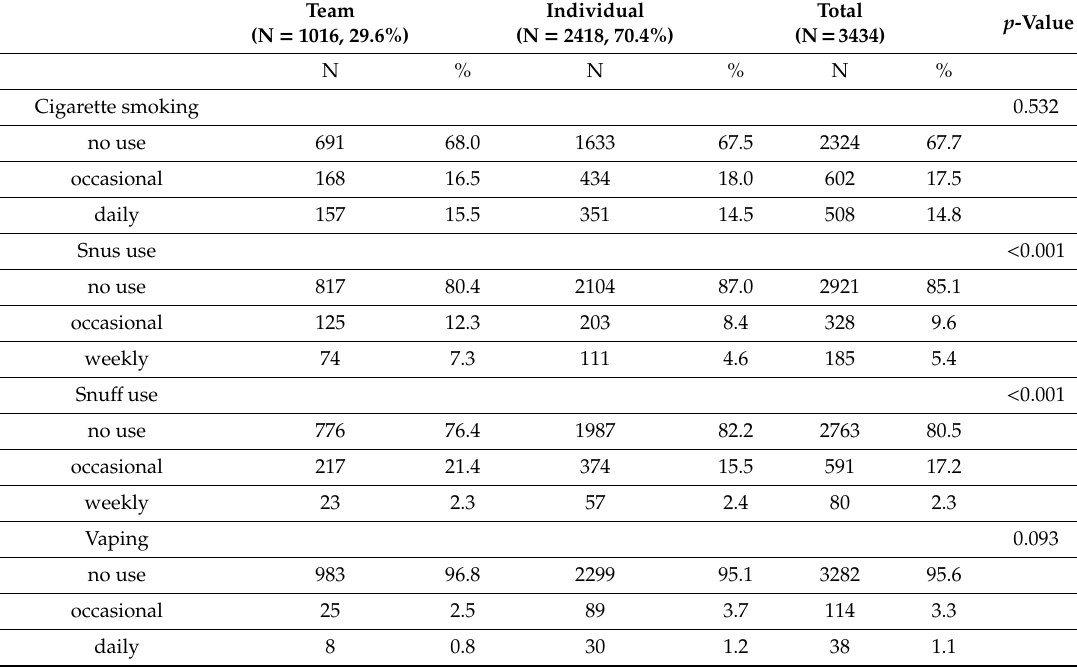
Table 3. Association between tobacco or nicotine use and type of sport (team / individual) (N =